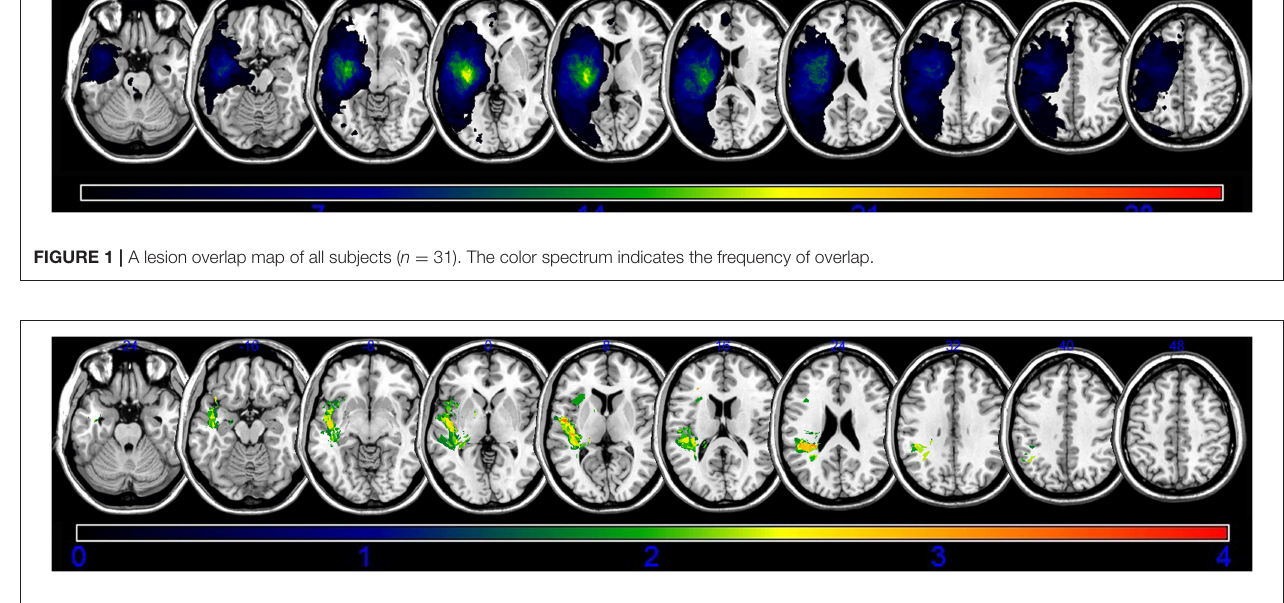
FIGURE 2 | Voxel-based lesion-symptom mapping of the total aphasia quotient after application of the non-parametric Brunner–Munzel test. The color scale indicates Brunner–Munzel rank order z statistics. Only voxels significant at p < 0.05 are shown. The statistical map shows voxels with a minimum Z score of 1.89797 and maximum range of 4, which was the maximum brightness.